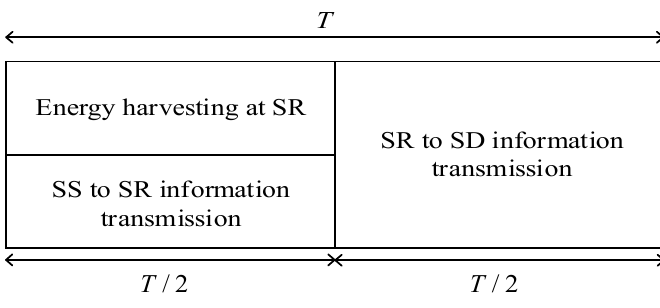
Figure 3. Transmission block structure in the PSR scheme.